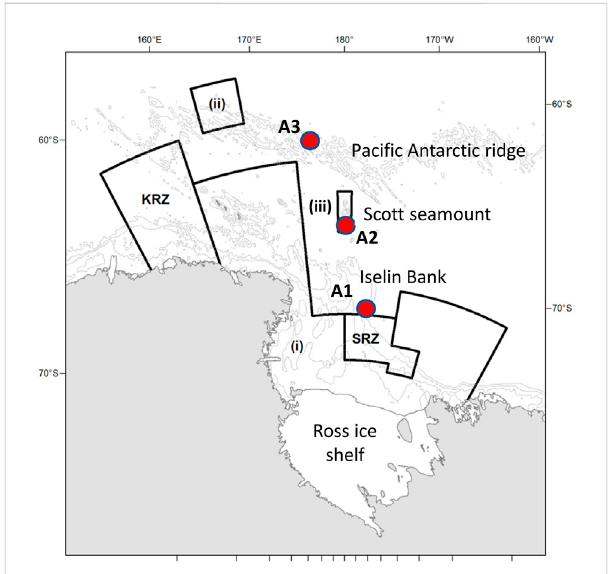
FIGURE 1 Location of the three moorings containing the AMARs (red circles, A1, A2, and A3). Also shown are the boundaries of the Ross Sea region marine protected area, which comprises: the General Protection Zone, composed of areas (i), (ii), and (iii), the Special Research Zone (SRZ), and the Krill Research Zone (KRZ). Depth contours are shown at 500, 1,500 and 2,500